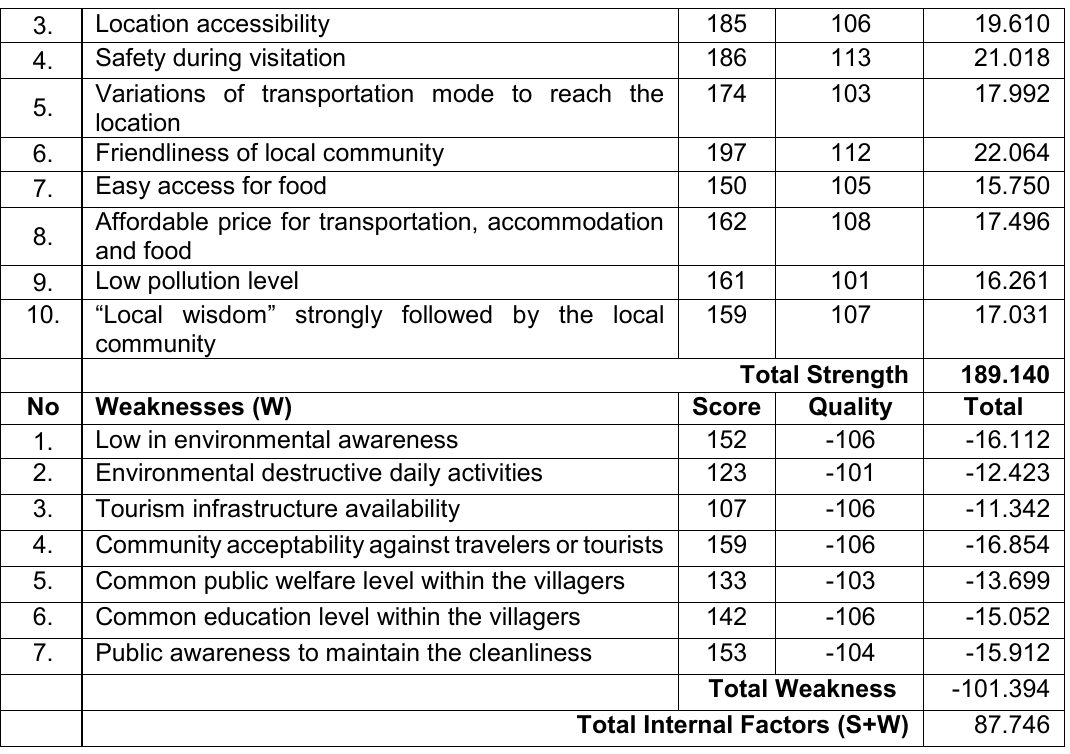
Table 4. Quantitative Evaluation for External